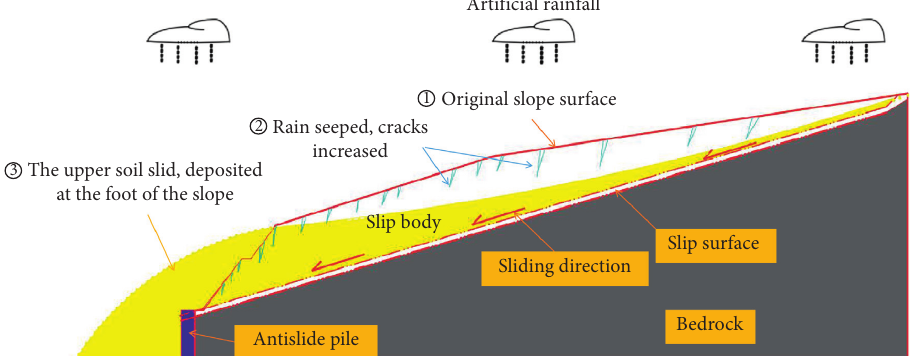
Figure 4: Schematic diagram of the landslide deformation process.